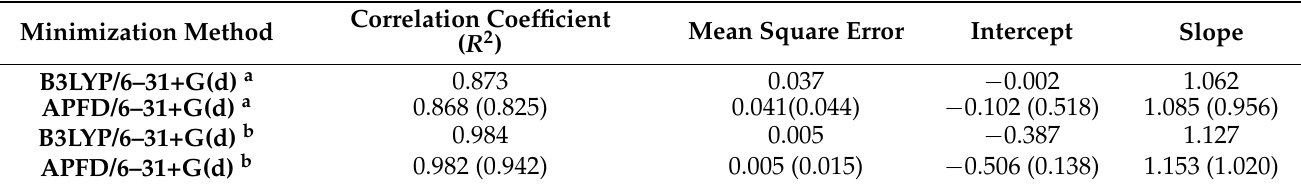
a Data of Figure 9A; calculation of 1 H NMR chemical shifts at the GIAO/B3LYP/6–311+G(2d,p) level and b data of Figure 9B; calculation of 1 H NMR chemical shifts at the GIAO/B3LYP/6–311+G(2d,p) level. The data in parenthesis were obtained at the GIAO with the same level of theory as geometry